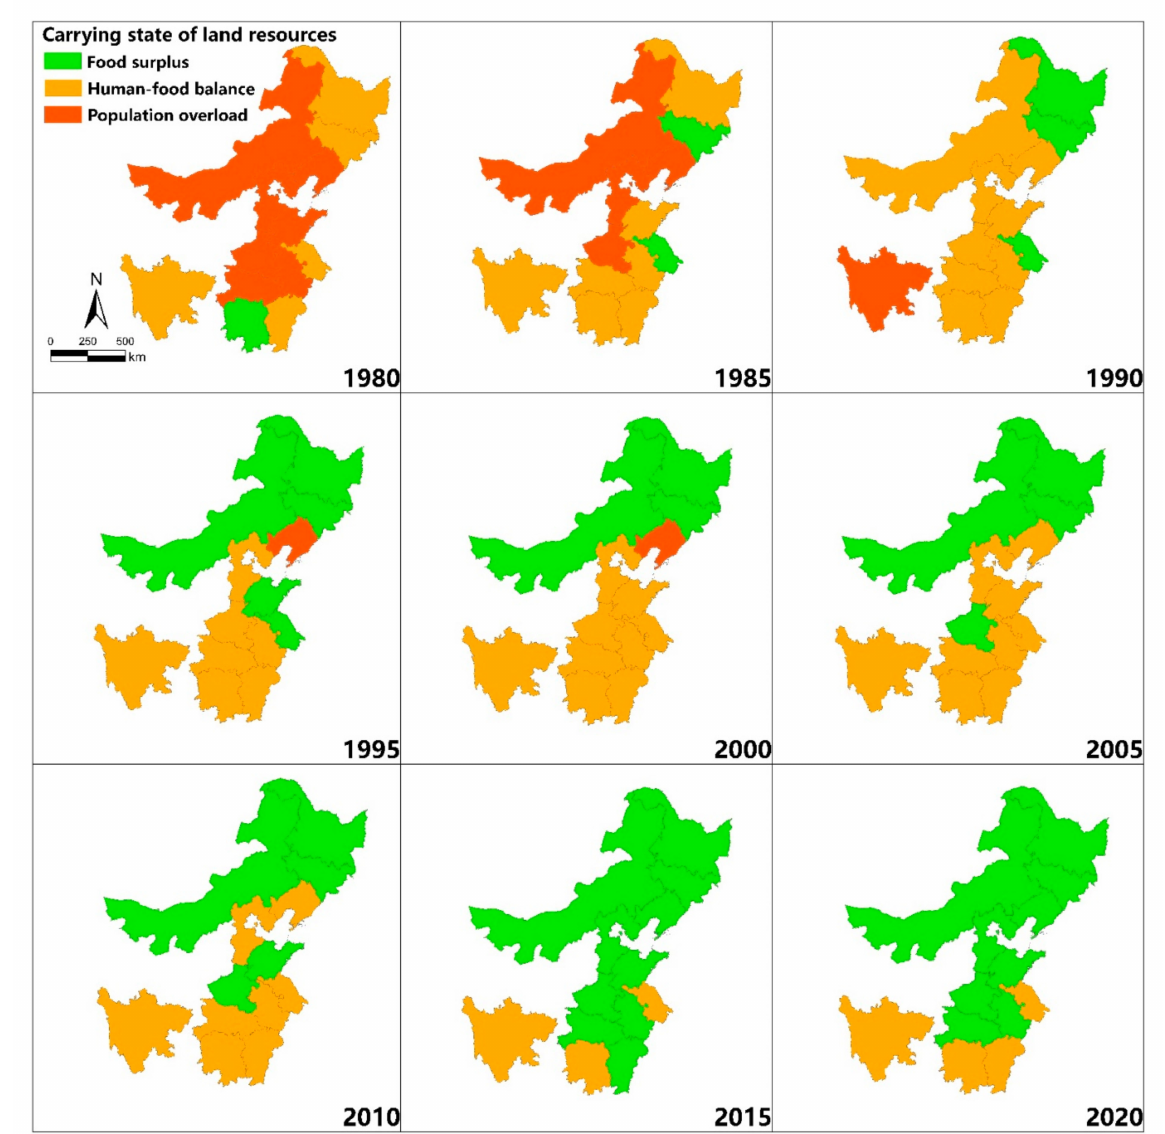
Figure 4. Spatial pattern of carrying state of land resources of China’s major grain-producing areas. As for the LRCCI, it can be explained by combining the land resource carrying capacity type. In terms of the spatial distribution of LRCCI, from 1980 to 1990, areas with population overload were dominated by North China, Sichuan, and Inner Mongolia; from 1990 to 2000, the population overload areas were mainly in Liaoning. As the human–grain relationship improved, from 2010 to 2020, the LRCCI was low in central and northern China but high in southern China, and in 2020, most provinces involved had a grain surplus, mainly Northeast China, North China, and Inner Mongolia. Northeast China is vast in territory and rich in resources, but it is scarcely populated, and its abundant black soil offers a great deal of arable land, thus ensuring its grain yield. Three provinces in North China are located in the North China Plain deposited by the Yellow River, Haihe River, and Huaihe River, and they are endowed with fertile soil; thus, they are suitable for large-scale grain cultivation. Inner Mongolia boasts vast stretches of arable land, lies in the Hetao region, and is ideal for growing plant corn, wheat, and other grain